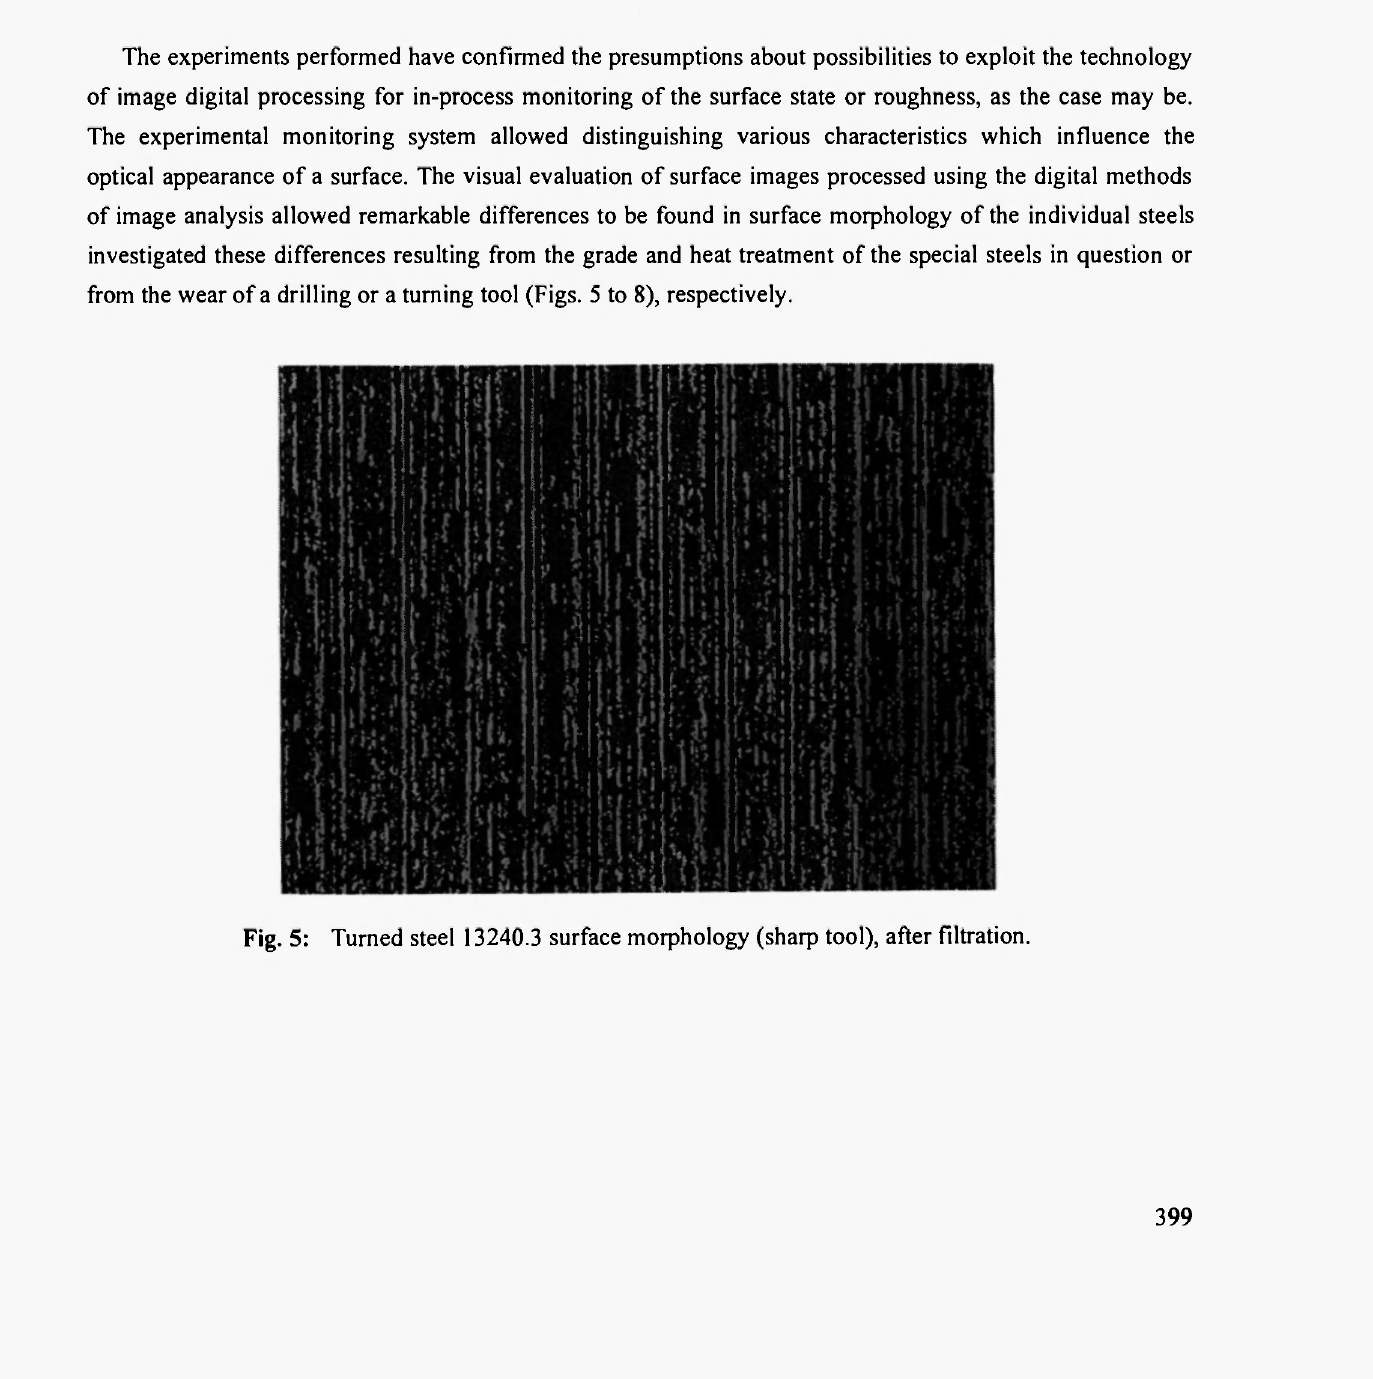
Fig. 5: Turned steel 13240.3 surface morphology (sharp tool), after